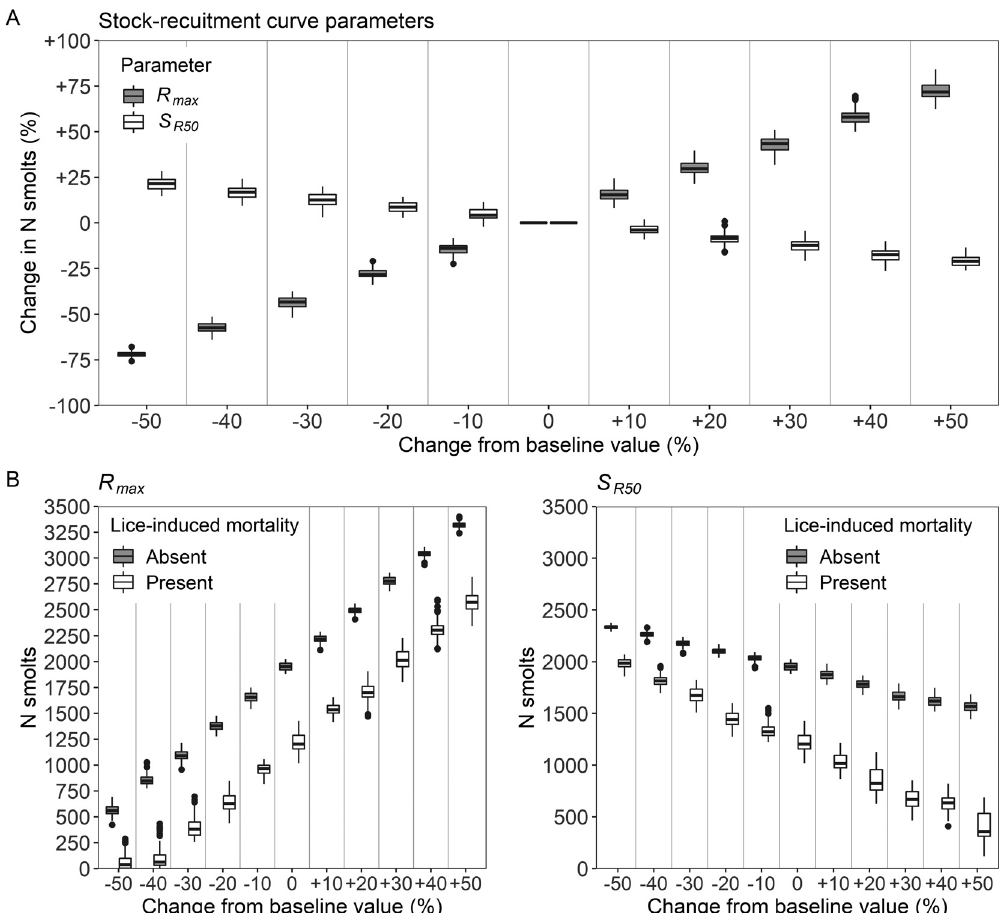
Fig. 9. Sensitivity of number of smolts to (A) parameters of stock-recruitment curve, and (B) parameters of stock-recruitment curve for conditions of lice-induced mortality being absent and present. In (A), simulations have been run under conditions of no lice-induced effects; in (B), no premature return was